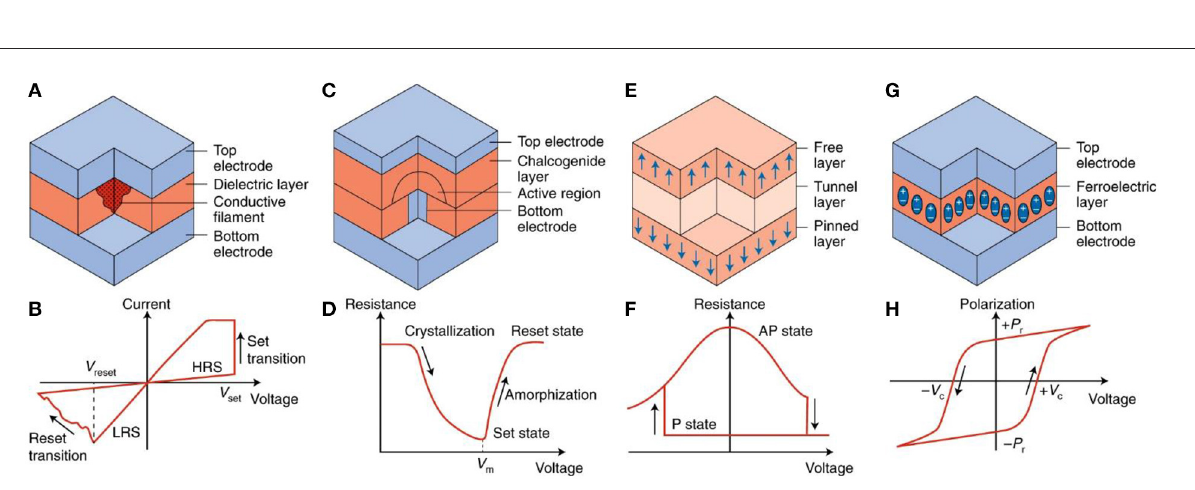
FIGURE7 Post-silicon nano-electronic device. (A) Conductive filament resistive memory (B) corresponding polar current-voltage characteristics (C) Phase-change memory (D) phase-change memory characteristics (E) Spin-transfer torque magnetic random-access memory (F) resistance-voltage characteristics of Spin-transfer torque magnetic random-access memory (G) ferroelectric random-access memory (H) polarization-voltage hysteresis characteristics (Ielmini and Wong,